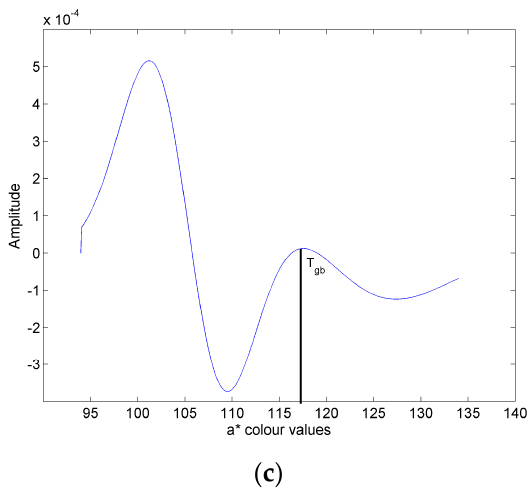
Figure 3. An image of corn ( a ), its smoothed probability distribution ( b ), and the difference of probability values ( c ). The inflection point in subfigure (b) (marked as T gb ) indicates the segmentation value. T gb is detected as the second peak in the difference curve (subfigure (c)).